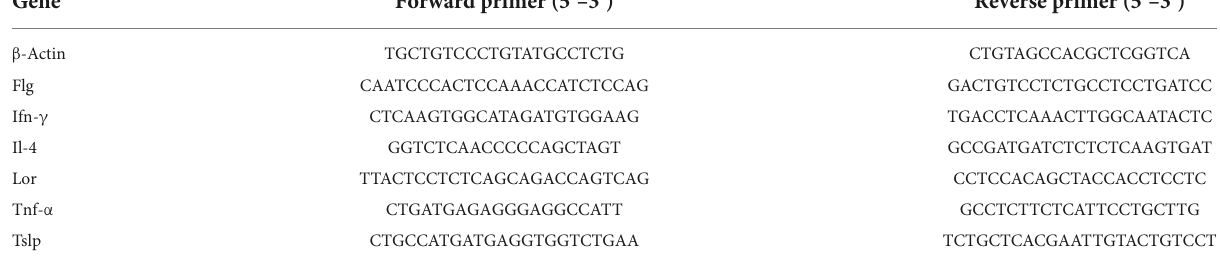
TABLE 2 Sequence of primers used for quantitative RT-PCR assay.